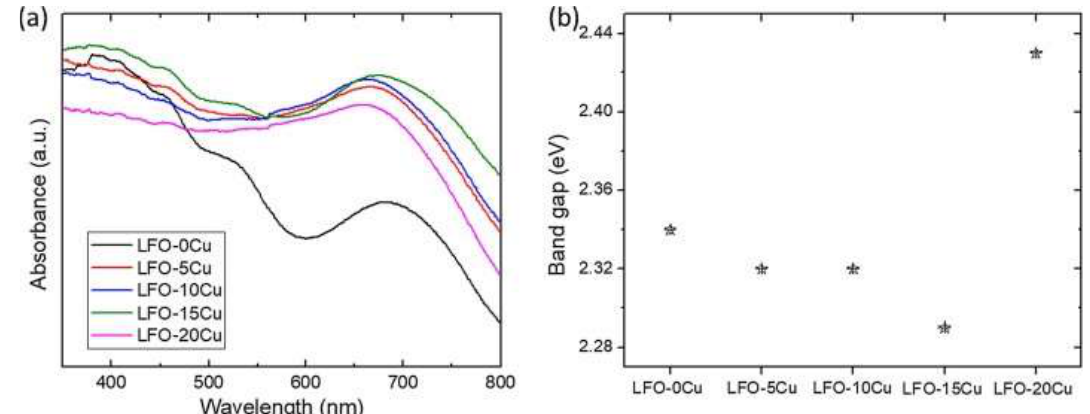
Figure 3. ( a ) UV–vis absorption spectra and ( b ) corresponding band gaps of LFO and LaFe 1-x Cu x O 3 . With permission from [76] .